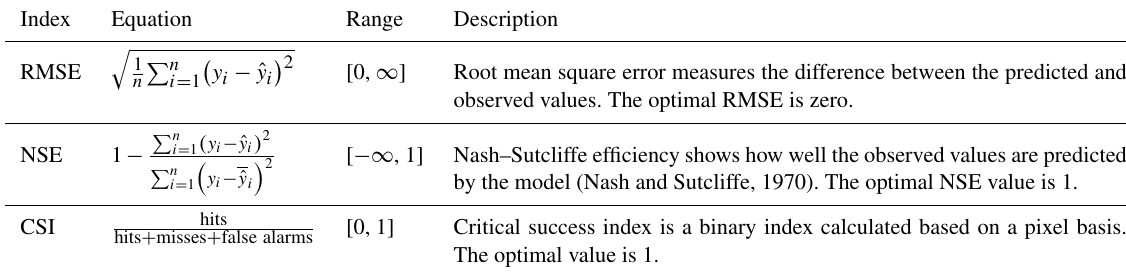
Table 3. Performance indices used to evaluate the models’ predictions. The y i and ˆ y i denote the water depth from the TELEMAC-2D model and the data-driven model respectively. ˆ y i is the average of water depths from the data-driven model. Hits, misses and false alarms are estimated by the contingency